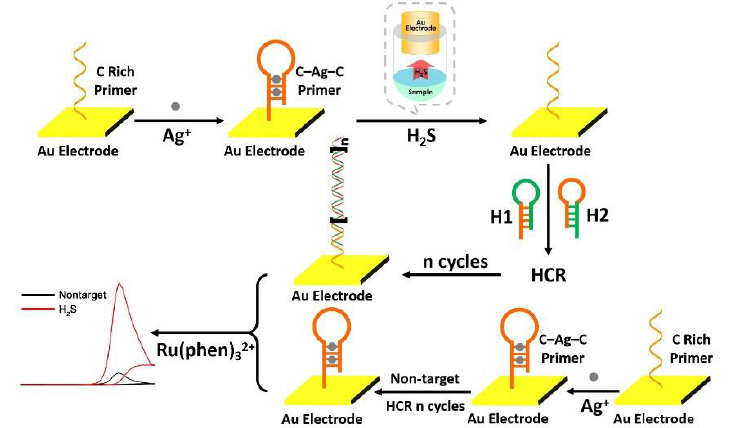
Figure 1. Schematic illustration of an ultrasensitive ECL biosensor for H 2 S detection based on ion interaction.